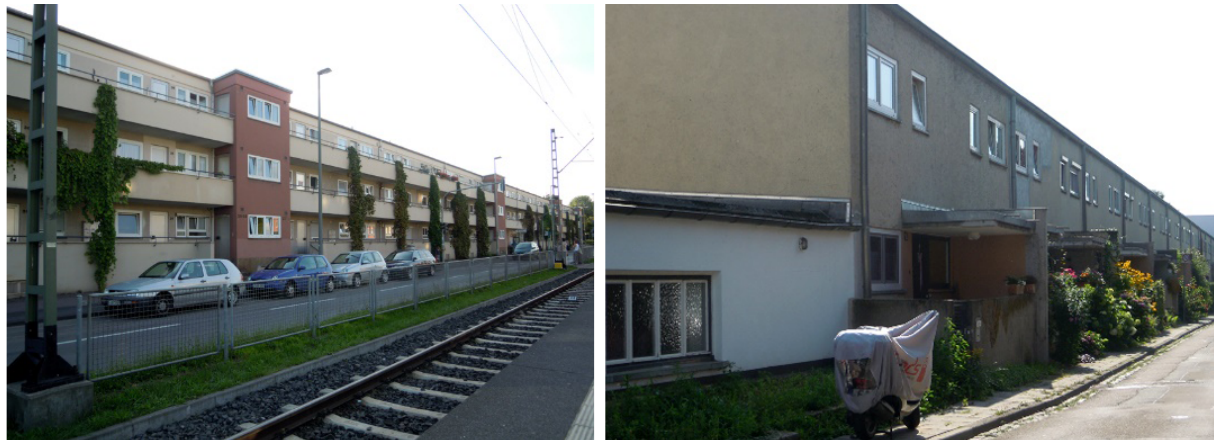
Figure 5. Praunheim (left) and Römerstadt (right), Frankfurt, by Ernst May. Source: